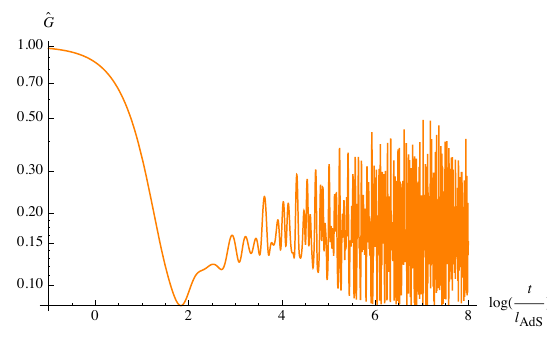
Figure 1 . The regularized two-point function